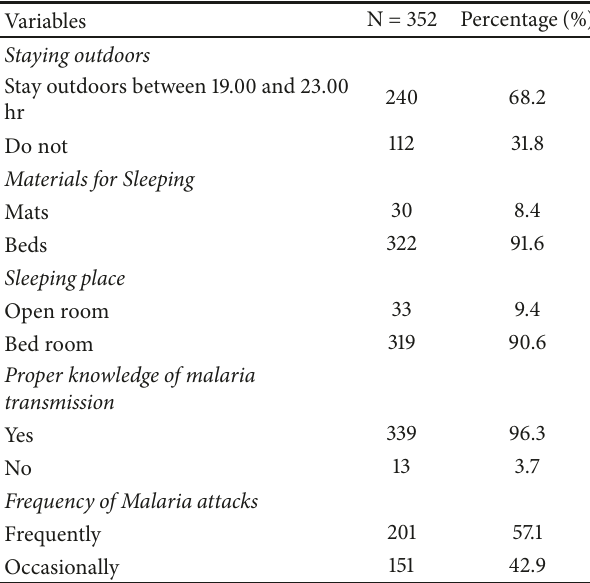
Table 4: Relationships between usage of LLINs and sociodemo- graphic characteristics of